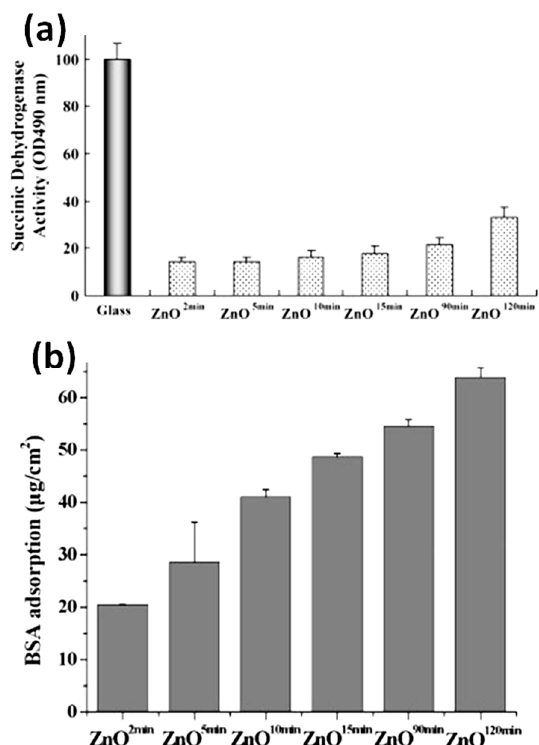
Figure 13. ( a ) Metabolic activity of NIH 3T3 cells cultured on ZnO films with different pore densities determined by the MTT method based on SDH activity. Cells were seeded at 10 4 cells/cm 2 and allowed to proliferate for 48 h. The data were expressed as mean ± SD ( n = 3); ( b ) BSA adsorption on porous ZnO films with different pore densities in 30 min. Modified with permission from reference [95]. Copyright (2011) Elsevier.